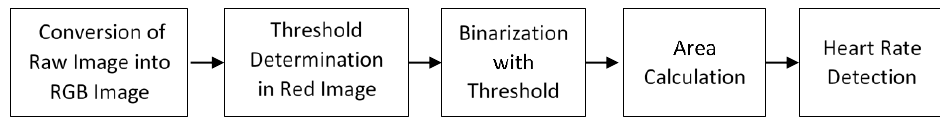
Figure 7. Procedure of the fingertip image intensity-based detection method.